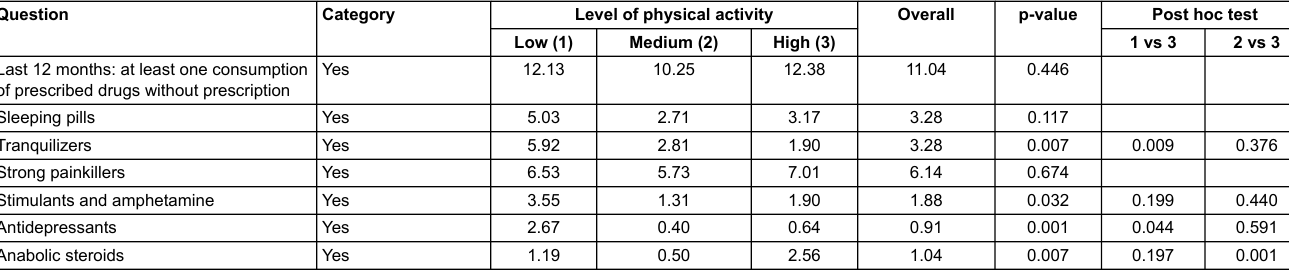
Table 8: Consumption of prescribed drugs without medical prescription by level of physical activity.